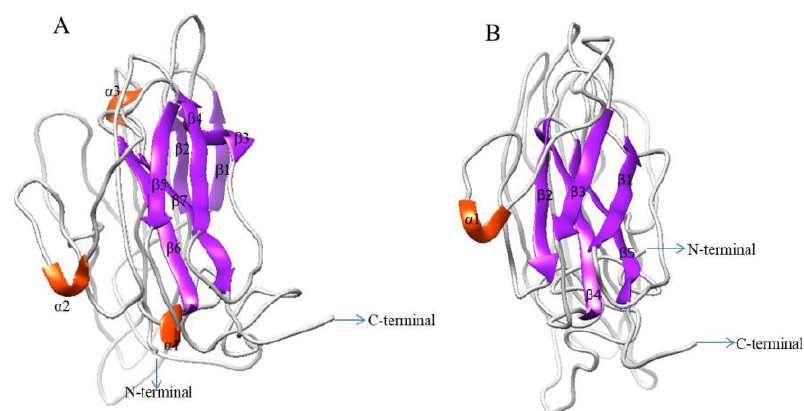
Figure 5. Comparison of 3D structure of IGFBP7 from ( A ) H. discus hannai and ( B ) H. madaka . N- and C- termini are marked with arrows. The structure was generated using I-TASSER server with a C- score between 2 and 4.